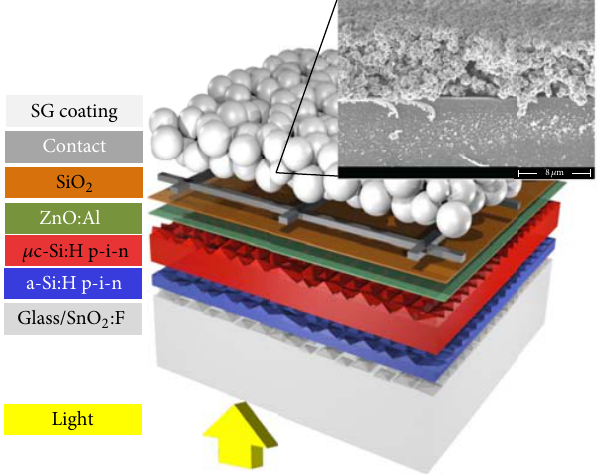
Figure 1: Three-dimensional schematic illustration of tandem thin- film silicon solar cell with hydrogenated amorphous silicon top solar cell and hydrogenated microcrystalline silicon bottom solar cell, deposited on Asahi U-type (SnO 2 :F) coated glass substrate (not to scale). The back side structure consists of 80 nm sputtered ZnO:Al and evaporated SiO 2 , cross-finger Ag contact and Snow Globe Coating TiO 2 as back reflector. A scanning electron microscopy image of SGC is presented on the top right side of the